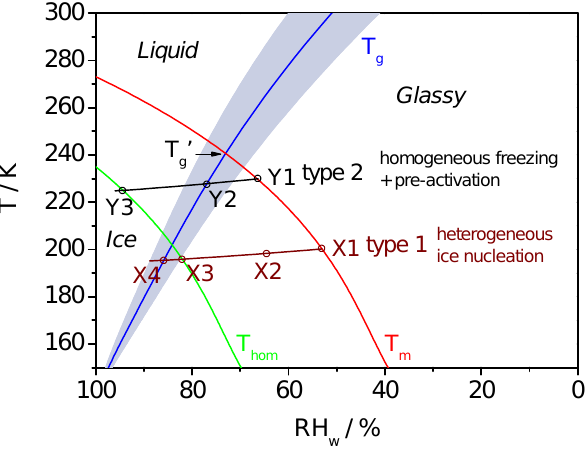
Fig. 1. Experimental trajectories (black and brown lines) of two types of AIDA expansion runs with aqueous raffinose aerosol par- ticles as a function of the relative humidity with respect to liquid water, RH w . T g denotes the glass transition temperature, T m the ice melting temperature, and T hom the homogeneous freezing tempera- ture. The computations of these curves as well as the details of the labelled points along the trajectories are discussed in the